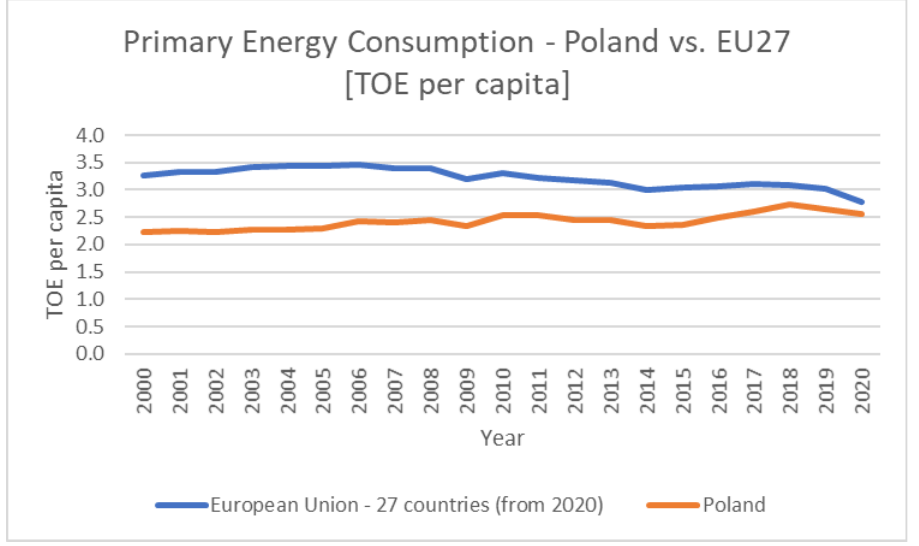
Figure 2. Primary energy consumption—Poland vs. EU-27 over the period 2000–2020 (toe per capita). Source: Own elaboration based on Eurostat data [20].